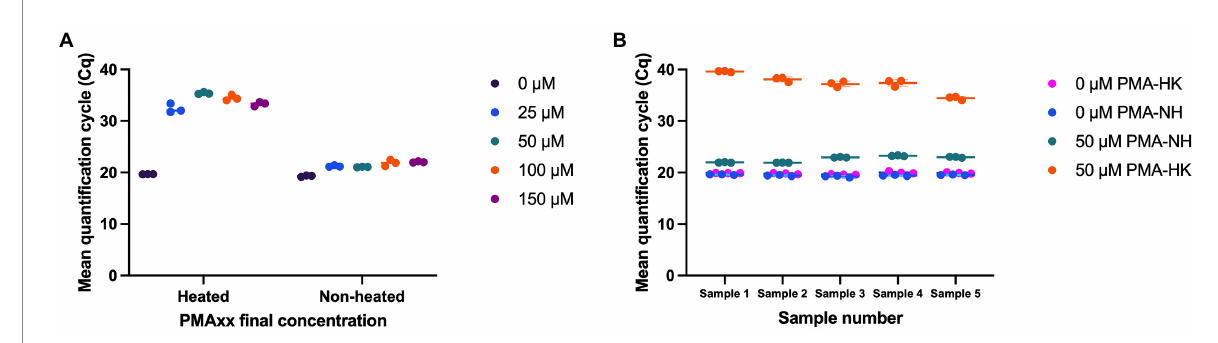
FIGURE 2 Optimization of viability treatment of L. paracasei 8700:2 strain-specific quantitative assay. (A) Final concentrations of PMAxx of 0, 25, 50, 100, and 150 μ M were evaluated. PMAxx at concentrations of 25, 50, 100, and 150 μ M resulted in significant shifts in Cq values from heat killed samples. PMAxx at a final concentration of 50 μ M was selected as a potential optimal concentration. (B) Confirming 50 μ M as an efficient PMAxx concentration using five mono-strain reference samples.